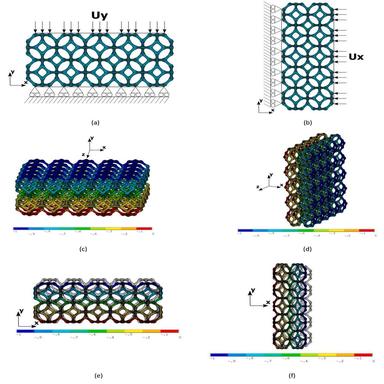
Ey evaluation on a 5 × 2 × 5 domain: (a) boundary conditions, (c) and (e) contour of y-displacement. Ex evaluation on a 2 × 5 × 5 domain: (b) boundary conditions, (d) and (f) contour of x-displacement.